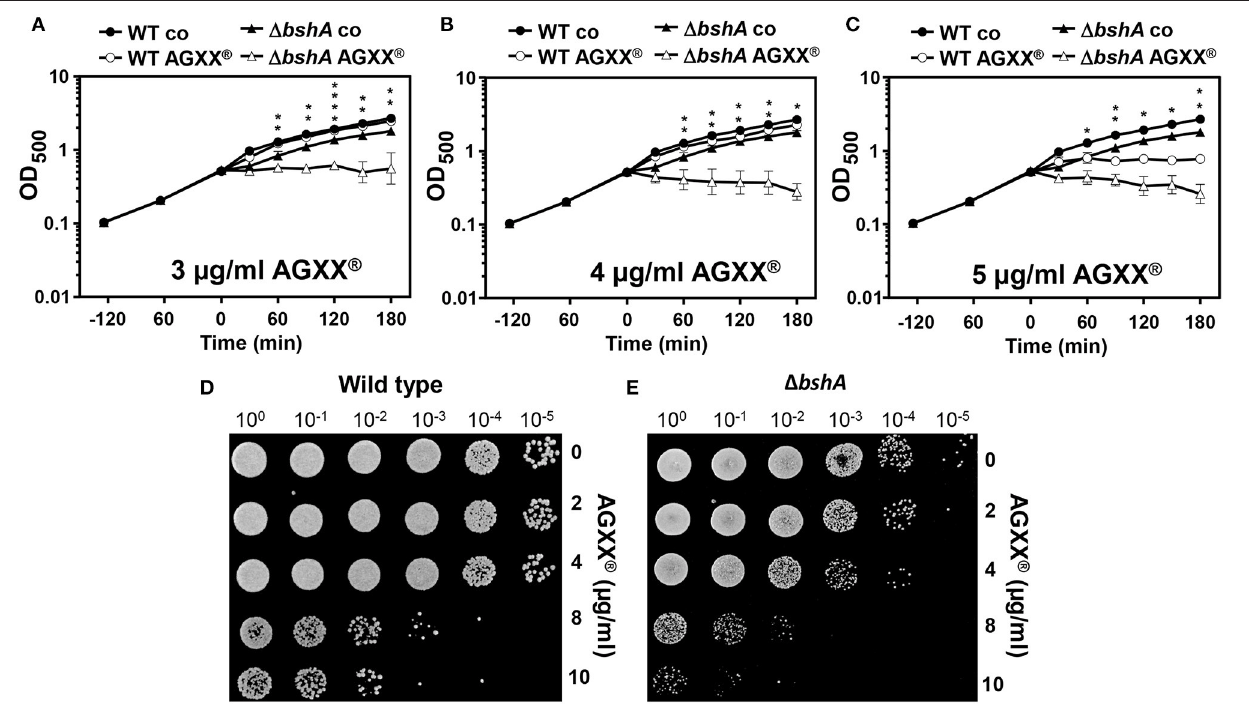
FIGURE 5 | BSH protects S. aureus against AGXX ® stress. Growth phenotype analyses (A–C) and survival assays (D–E) were performed for the S. aureus USA300 wild type (WT) and the bshA mutant before and after exposure to AGXX ® stress. (A–C) For growth comparisons, strains were exposed to 3, 4, and 5 µ g/ml AGXX ® stress at an OD 500 of 0.5. The results are from 3 biological replicate experiments. Error bars represent the SD and the statistics was calculated using a Student’s unpaired two-tailed t -test by the graph prism software. Symbols are defined as follows:* p ≤ 0.05; ** p ≤ 0.01 and **** p ≤ 0.0001. (D–E) For survival assays, S. aureus USA300 wild-type (D) and the bshA mutant (E) were grown in RPMI until an OD 500 of 0.5 and treated with 2–10 µ g/ml AGXX ® . Survival assays were performed by spotting 10 µ l of serial dilutions after 2 and 3h of AGXX ® exposure onto LB agar plates to observe CFUs after 24h incubation.